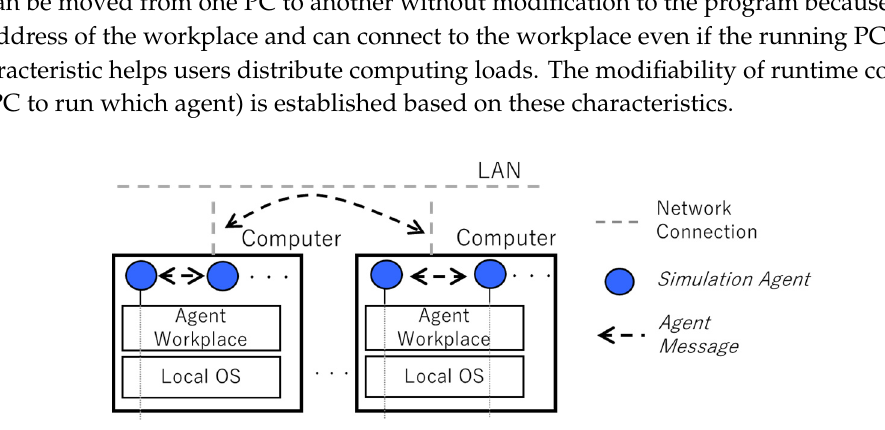
Figure 8. Example structure of multiagent simulation model using prototyped simulation modeling environment.